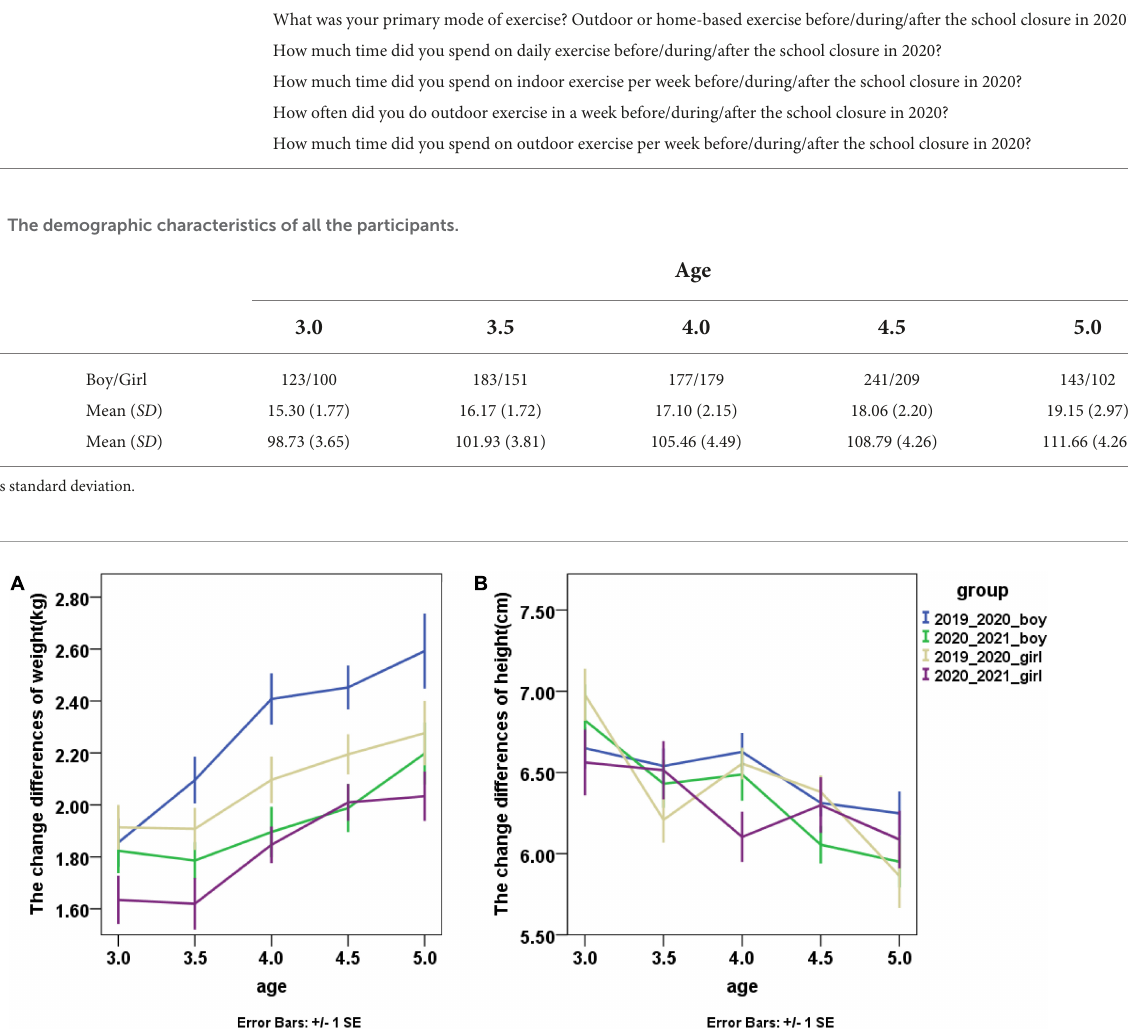
TABLE 1 The questions about the exercise profile in the telephone survey.